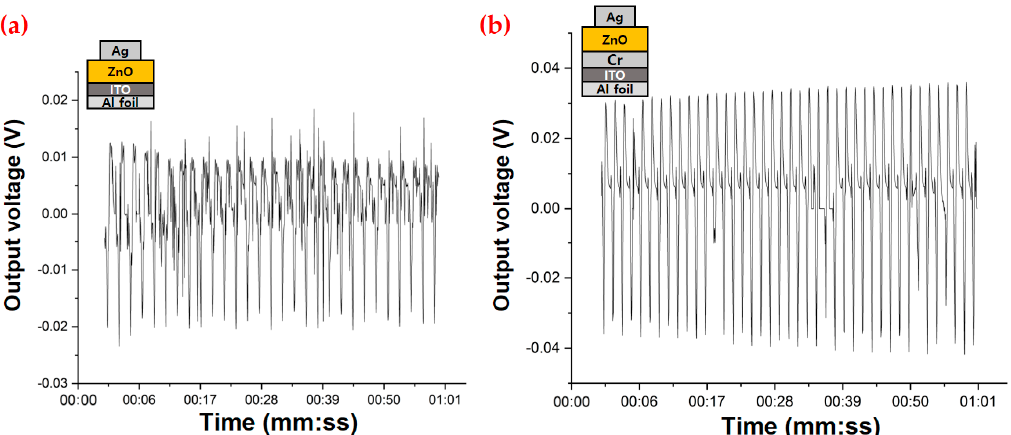
Figure 4. Examples of raw output voltages of ( a ) Ag/ZnO/ITO/Al-foil and ( b ) Ag/ZnO/Cr/ITO/Al-foil structured devices. Here, the device with a thin Cr layer exhibits a significantly more stable output waveform and increased peak-to-peak voltage than the device without the Cr layer.